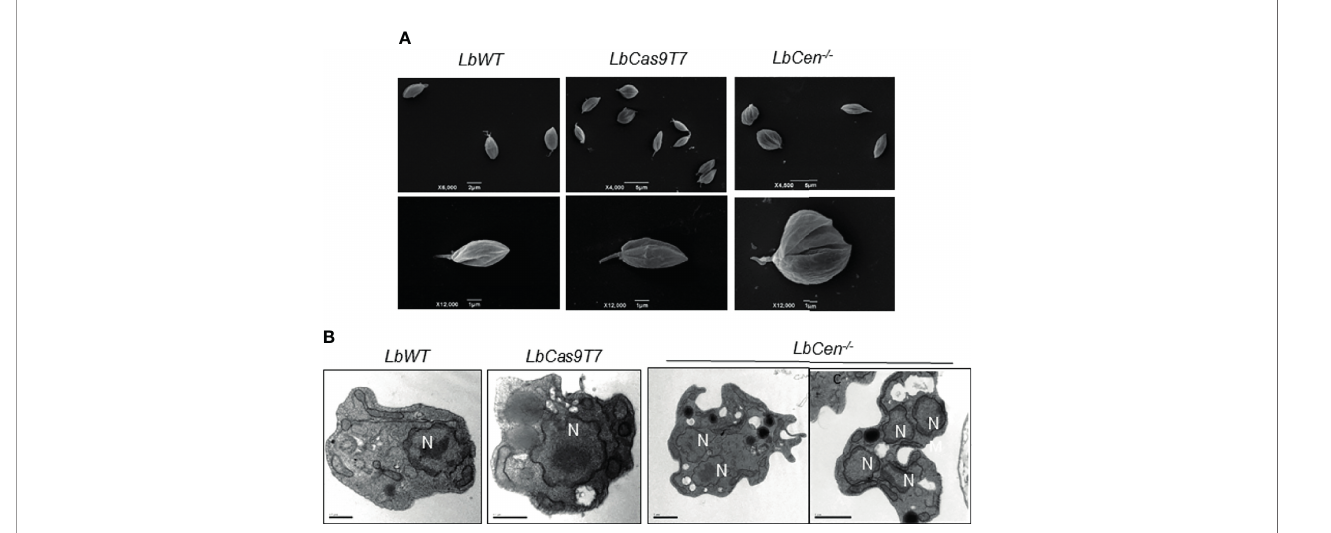
FIGURE 6 | Ultrastructural analysis of LbCen − / − axenic amastigotes. Lb WT, LbCas9T7 , and LbCen − / − axenic amastigotes were harvested, fi xed and prepared for scanning (A) or transmission electron microscopy (B) . Transmission electron micrographs of axenic amastigotes showing the presence of a single nucleus (N) in Lb WT and in LbCas9T7 and the presence of multi nuclei in LbCen − / − . Scale bars, 0.5 µm ( LbWT and LbCas9T7 ); 1 µm ( LbCen − / −